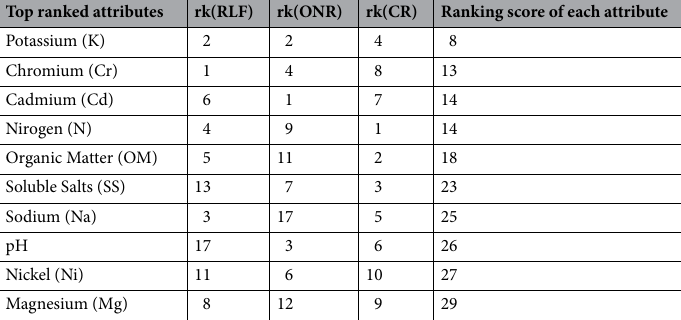
Table 4. List of Top Ranked Attributes for C. burnetii soil attribute dataset.